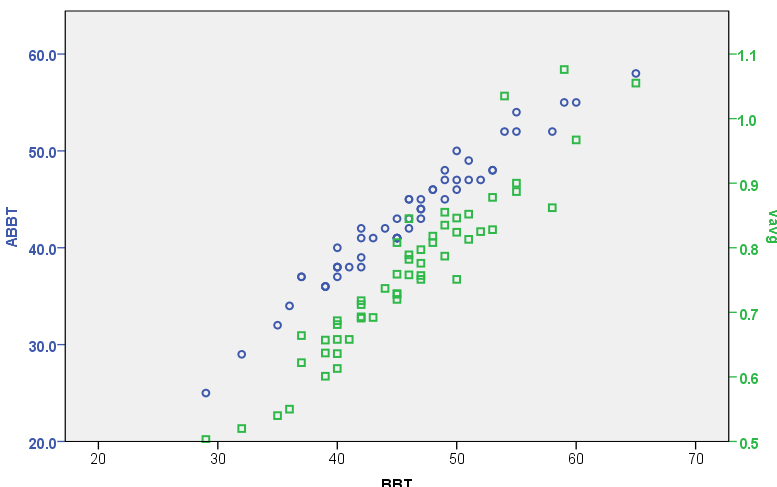
Figure 9. Correlation plot among test outcomes: automatic scoring (ABBT), manual counting (BBT) and average velocities ( V avg ). BBT score is considered as